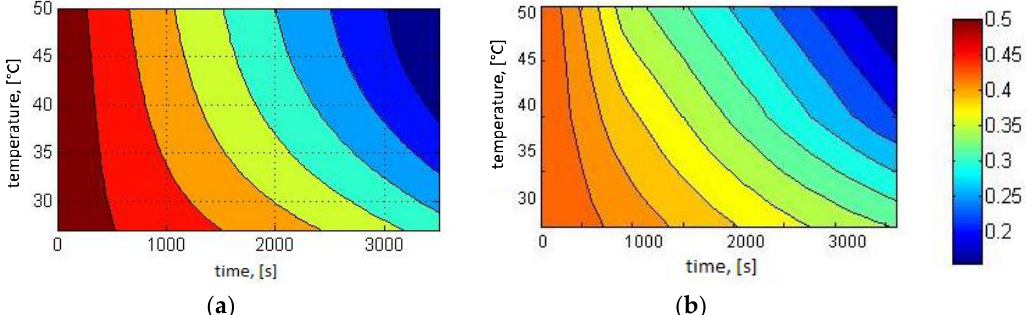
Figure 17. Comparative study of the influence of drying air temperature and time on the moisture content of coal (%), 2D installation; 0-8 mm, temperature 27–50 °C for: ( a ) Bełchatów; ( b ) Turów.